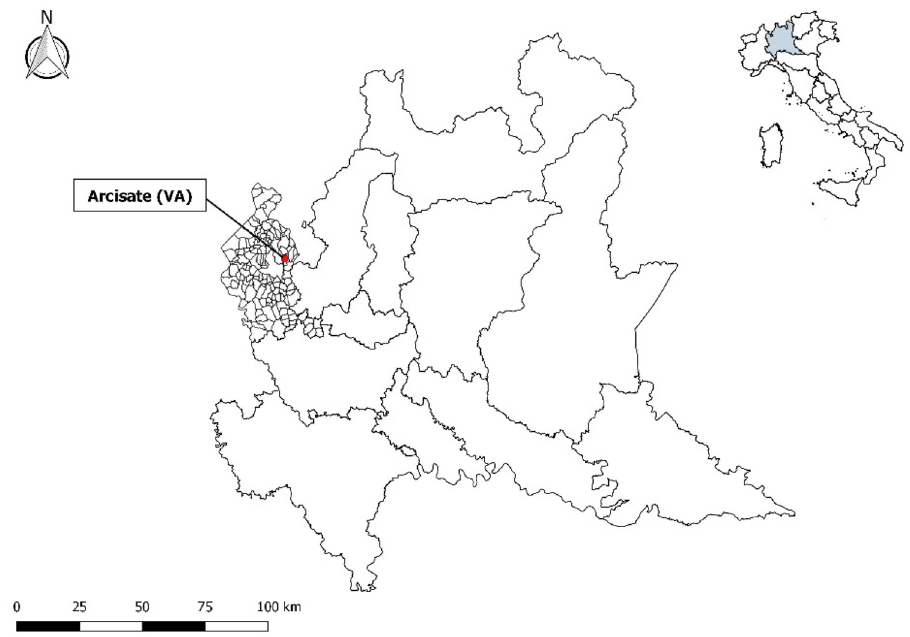
Fig. 2 Localization of Arcisate (VA) in the northeast part of Lombardy